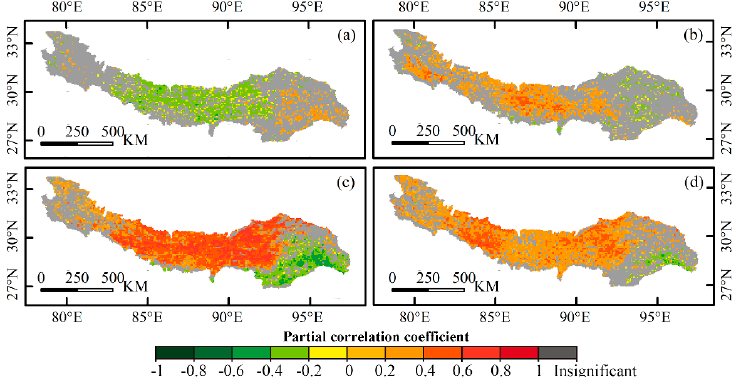
Figure 9. Spatial patterns of partial correlation coefficients between autumn NDVI and four climatic factors: temperature ( a ), precipitation ( b ), downward long-wave radiation ( c ), and downward short-wave radiation ( d ).